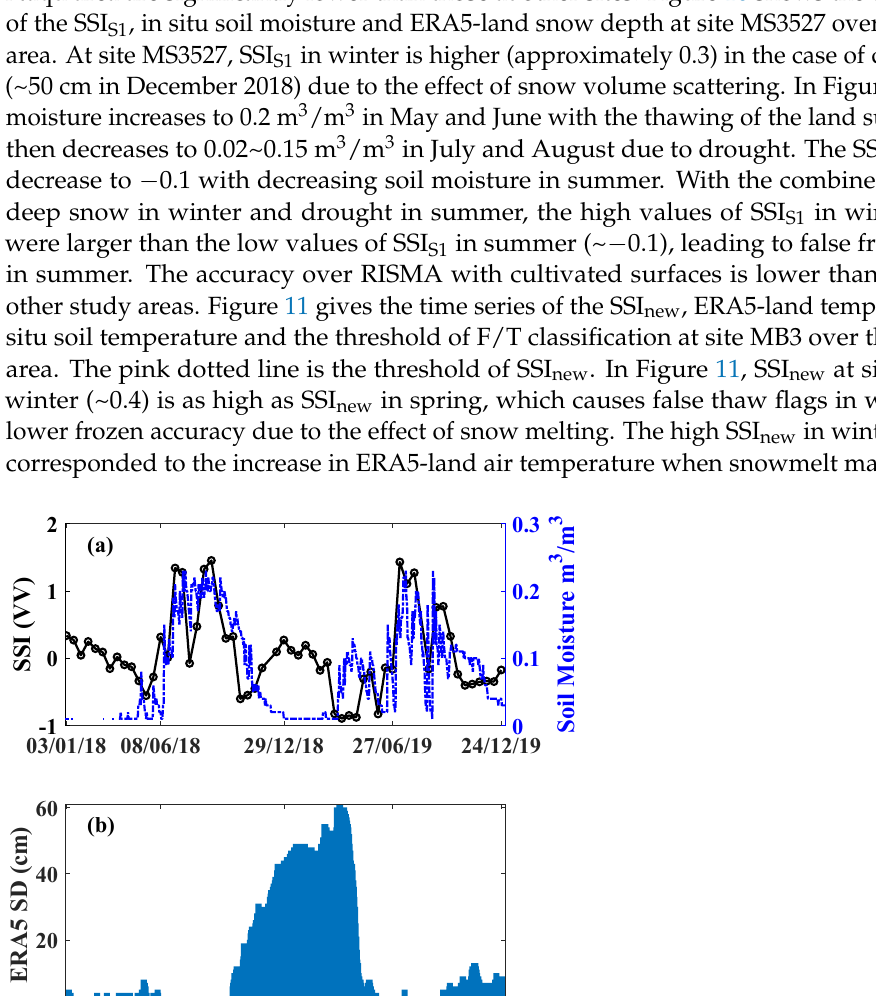
15 of 29 Table 5. Classification accuracy (%) statistics for F/T new over four study areas. Area F_Right T_Right Total_Right Genhe watershed